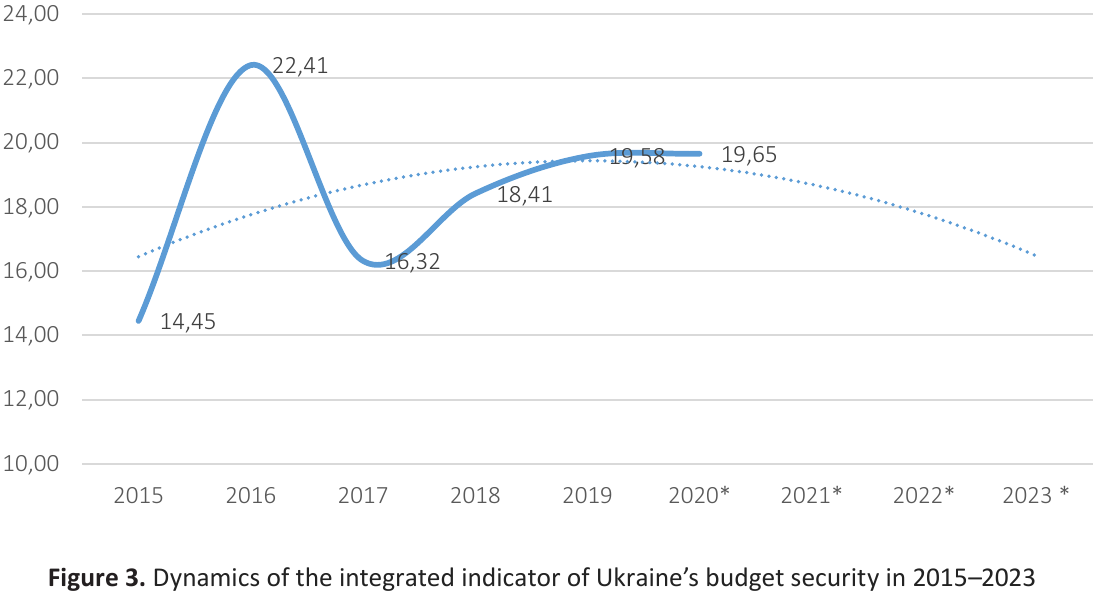
Figure 3. Dynamics of the integrated indicator of Ukraine’s budget security in